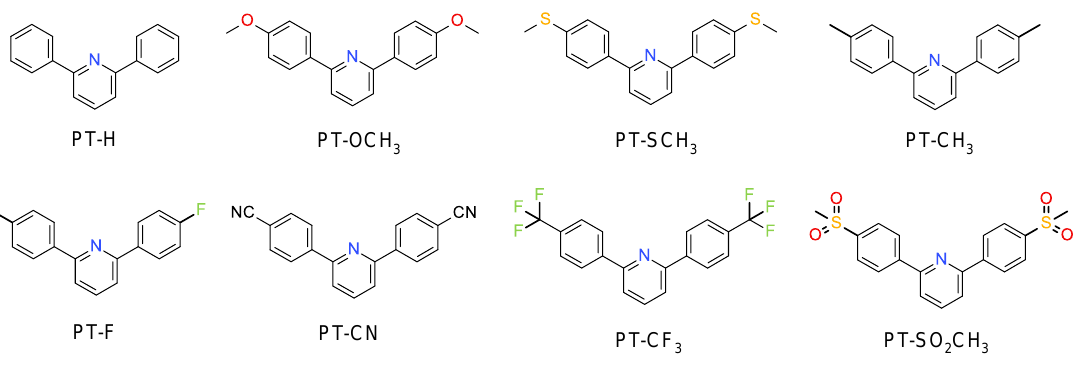
Scheme 1. Structures of molecular fluorescent sensors.